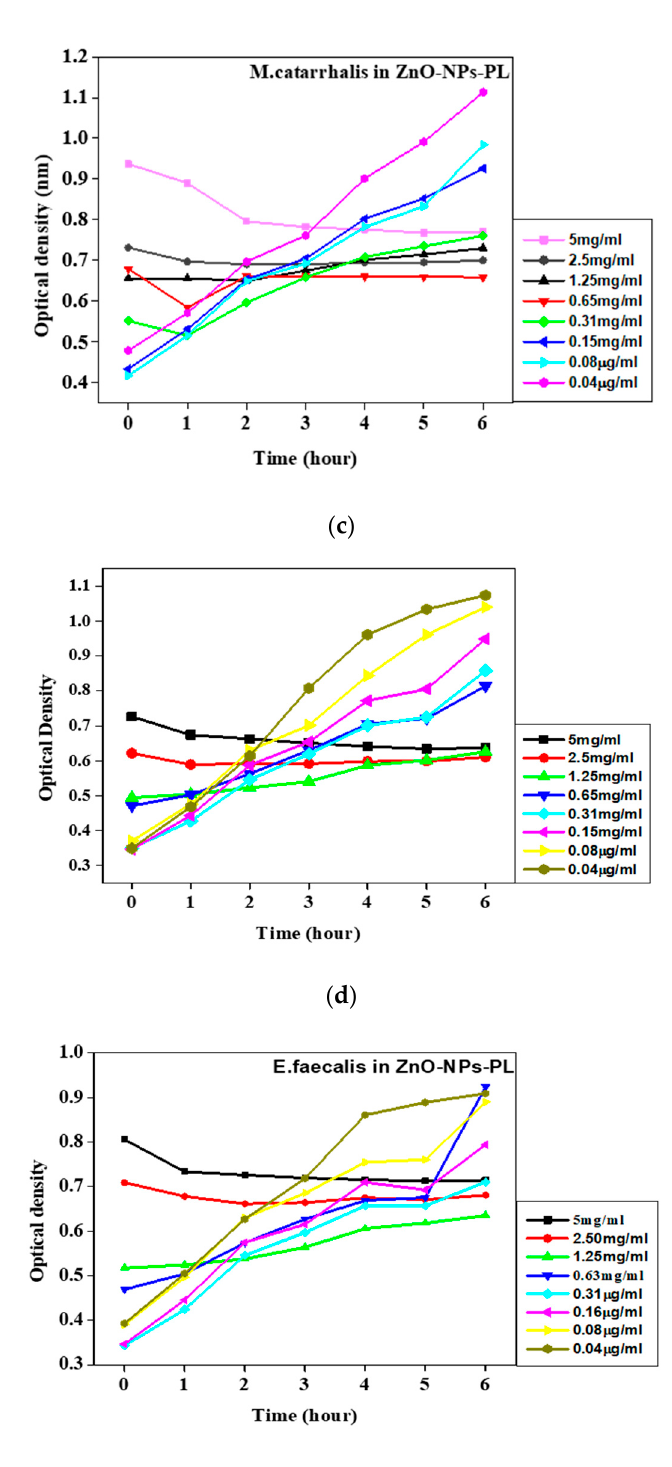
Figure 13. ( a ). Effect of time on persistence (survivability) of individual pathogenic strains in 5 mg/mL zinc oxide nanoparticles. ( b ). Effect of time on persistence (survivability) of individual pathogenic strains in 2.5 mg/mL zinc oxide nanoparticles. ( c ). Effect of time on persistence (survivability) of M. catarrhalis in zinc oxide nanoparticles. ( d ). Effect of time on persistence (survivability) of S. aureus in zinc oxide nanoparticles. ( e ). Effect of time on persistence (survivability) of E. faecalis in zinc oxide nanoparticles.